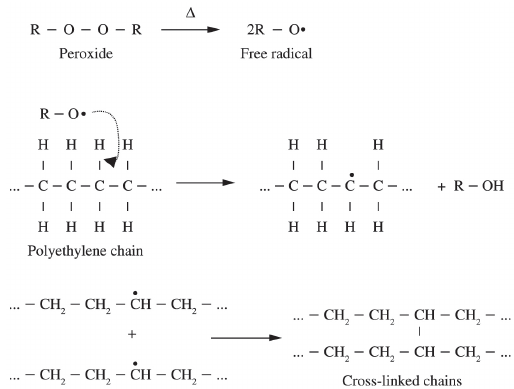
Figure 1. Scheme of the mechanism of peroxide polyethylene crosslinking 11 .